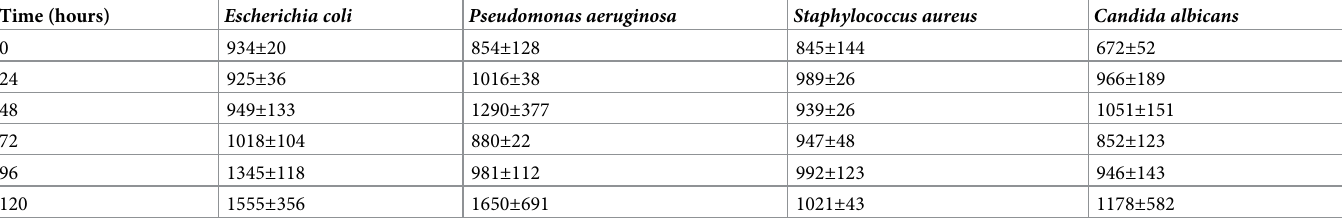
Table 1. Average change from baseline in concentration of unencapsulated bupivacaine in μ g/mL where treatment group data are the mean concentrations (n = 3) of three vials ± one standard deviation. Time (hours) Escherichia